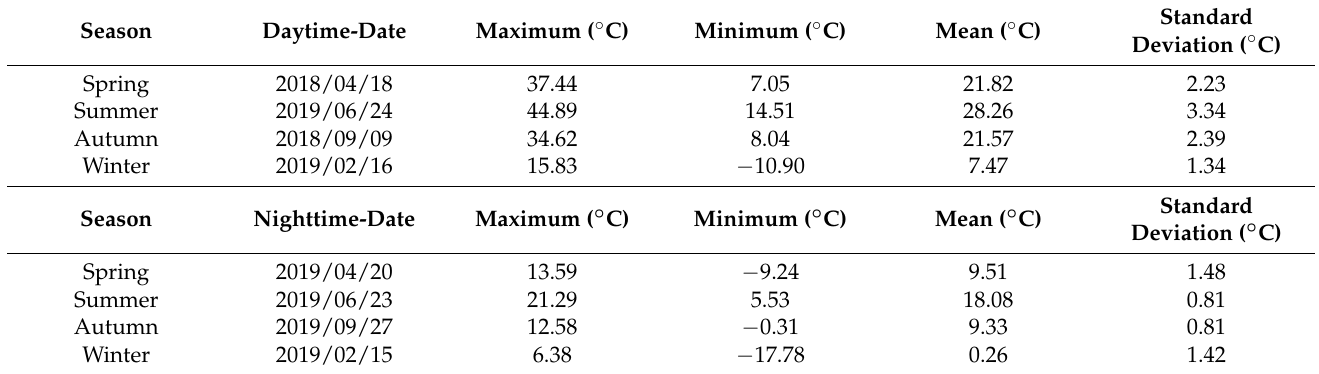
Table 4. The statistical overview of the collected LSTs for all seasons (Date format: